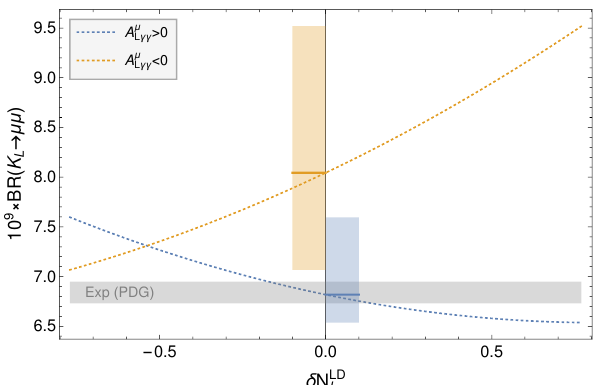
Figure 3 . The SM theoretical error of BR( K L → µ ¯ µ ) due to the uncertainty in the long-distance